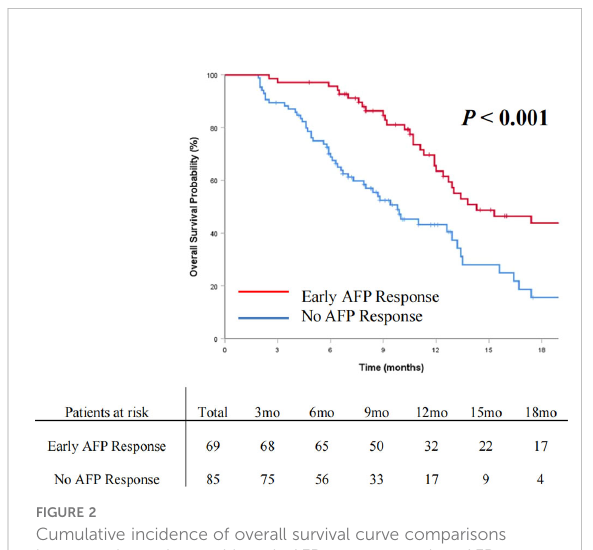
FIGURE 3 Cumulative incidence of progression-free survival curve comparisons between the patients with early AFP response and no AFP response in the entire